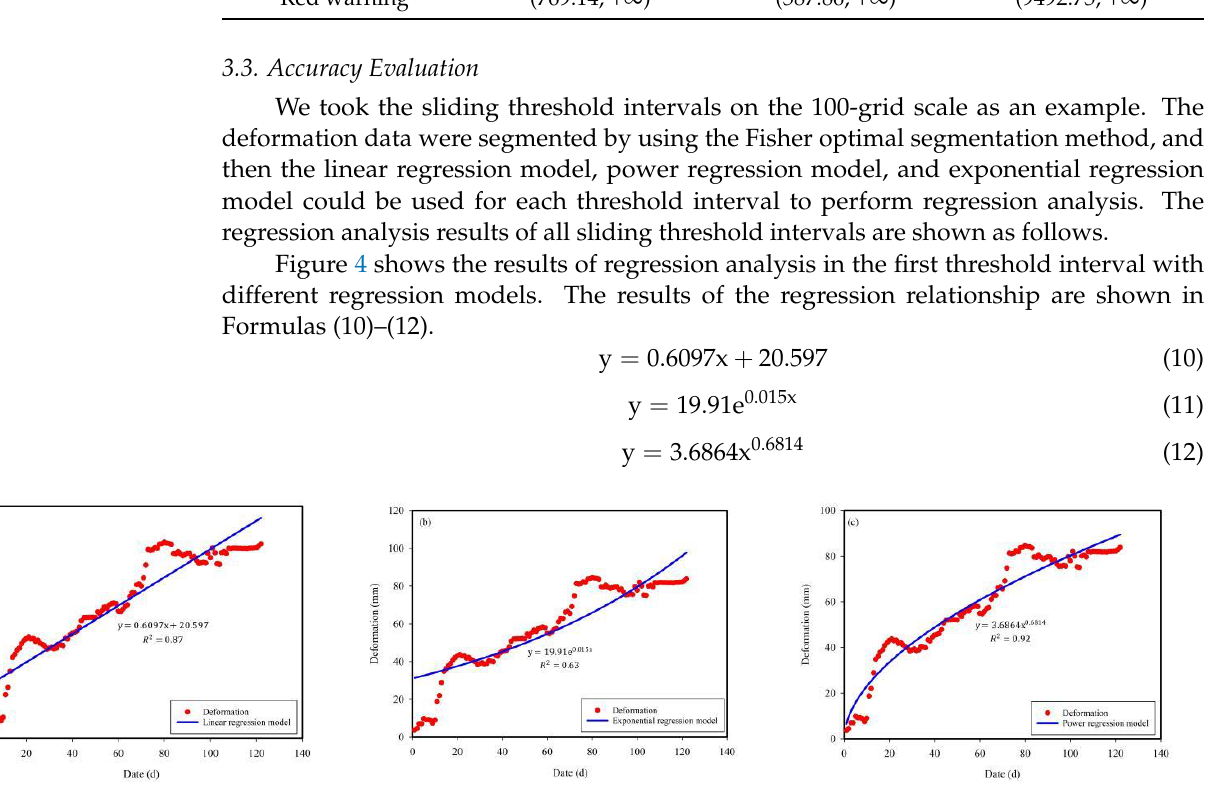
Figure 5. The results of regression analysis in the second threshold interval with different regression models. ( a ) Linear regression model; ( b ) exponential regression model; ( c ) power regression model.